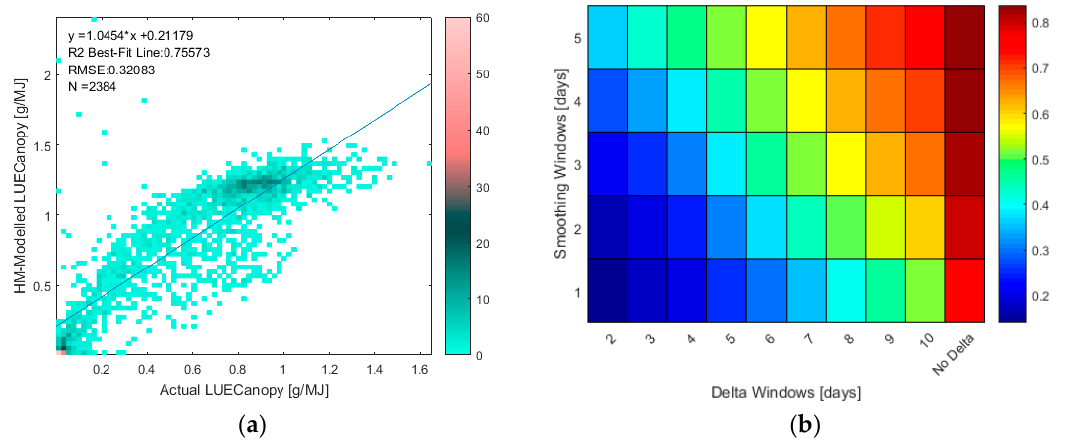
Figure 2. ( a ) Comparison of actual versus Hybrid-Maize modeled LUE Canopy . The color bar represents the number of points at each marker on the scatter plot. ( b ) R 2 of actual versus Hybrid-Maize modeled LUE Canopy and Δ LUE Canopy at different levels of smoothing and values of Δ . N = 2384.